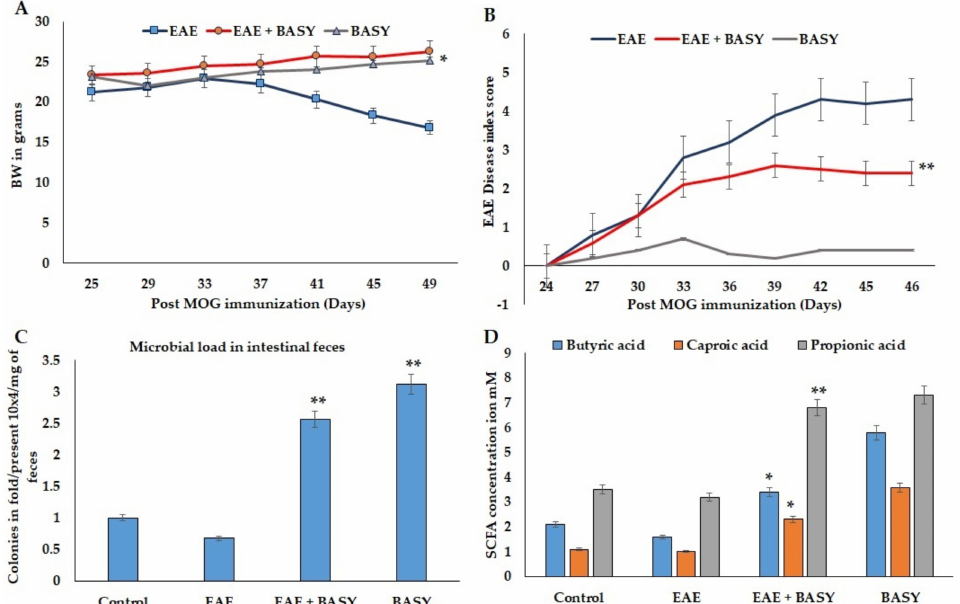
Figure 1. BASY effectiveness on different parameters of MOG-induced EAE mice. The mice were immunized with MOG 35-33 (emulsified with CFA using a T connector). BASY induced the tolerance against EAE induction in mice: ( A ) Body weight (BW) of mice (EAE, EAE+BASY and BASY-treated mice). ( B ) Clinical symptoms recorded post-MOG immunization resulted in gradual increase in paralysis and hind limb inactivity, noted from 11 days of MOG immunization, which became stable after the 18th day post immunization. ( C ) The total microbial load in pre-administered BASY for 25 days of pre-immunization and MOG-immunized mice after the 16th day. The total bacterial count in fecal samples before and after BASY treatment (Group 1: untreated control group; Group 2: MOG-immunized mice (EAE); Group 3: BASY treated with MOG immunization (EAE+BASY); Group 4: BASY–only treated mice). The uncharacterized colonies were counted using the colony counter and recorded as 10 4 colonies/gram of fecal samples. ( D ) SCFAs, butyric acid, caproic acid, and propionic acid were quantified using Biovision biochemical kits in the ileal content. The values are measured using a microplate reader and expressed as mM/mg of ileal content. Data were pooled from three independent experiments and shown as mean ± SD. * p < 0.05, ** p < 0.01. ( A ) microbial load compared using a student t -test. ( B ) SCFA content was compared using a one-way